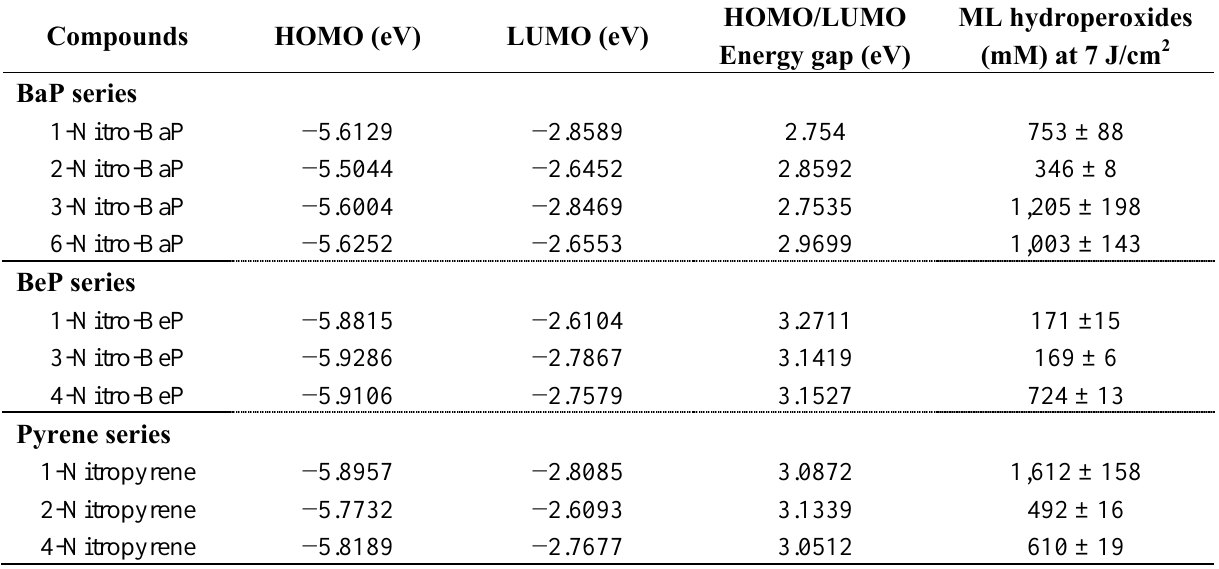
Table 2. Quantum computation results of HOMO/LUMO energy gap of nitro-PAHs.